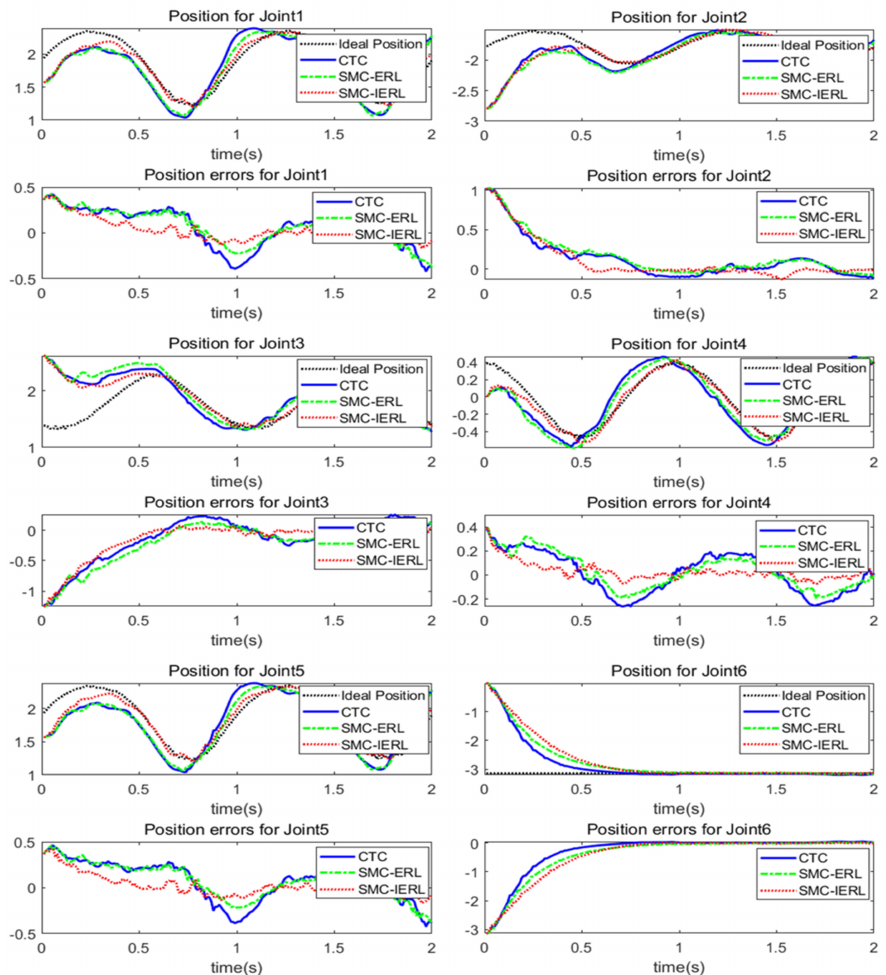
Figure 10. In the non-uniform circular trajectory experiment without considering disturbance signal, the expected position of each joint is compared with the position and error of each joint obtained by the three control